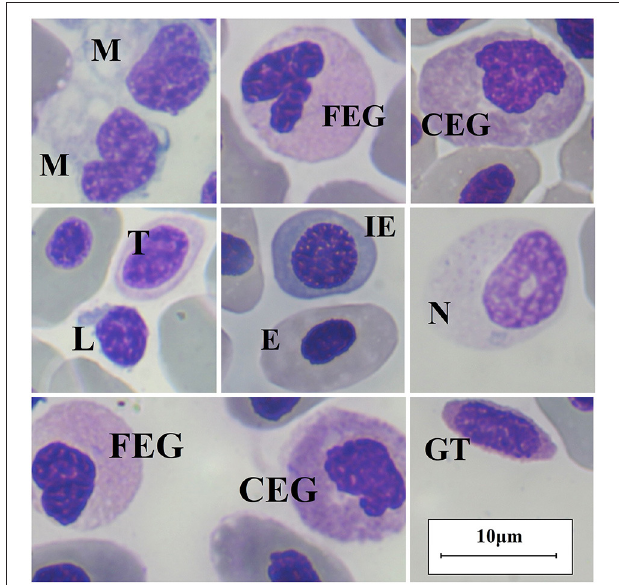
FIGURE 1 | Nursehound Shark ( Scyliorinus stellaris ) main peripheral blood cells. Diff-Quick stain and optic microscopy 100x using immersion oil. M, monocyte; FEG, fine-eosinophilic granulocyte; CEG, coarse-eosinophilic granulocyte; L, lymphocyte; T, thrombocyte; E, erythrocyte (mature); IE, immature erythrocyte; N, neutrophil; GT, granulated thrombocyte.